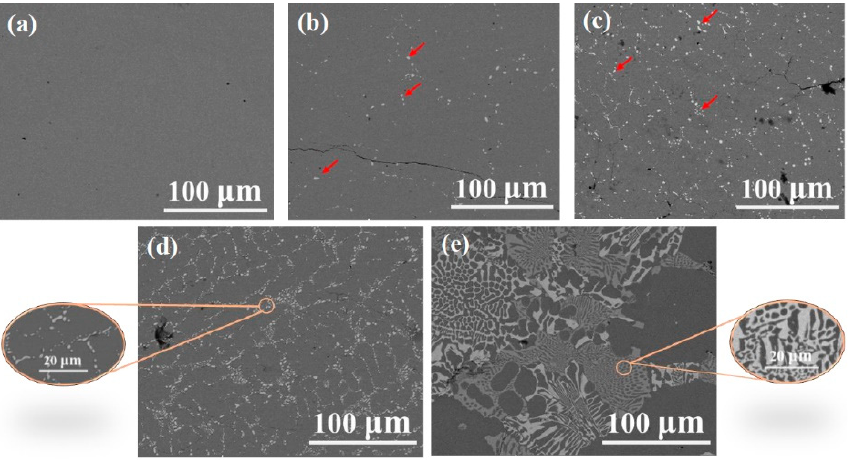
Figure 2. Backscattered electron images of Ni 48 Mn 39 Sn 13 − x Tb x alloys ( a ) x = 0; ( b ) x = 0.5; ( c ) x = 1; ( d ) x = 2; ( e ) x = 5.